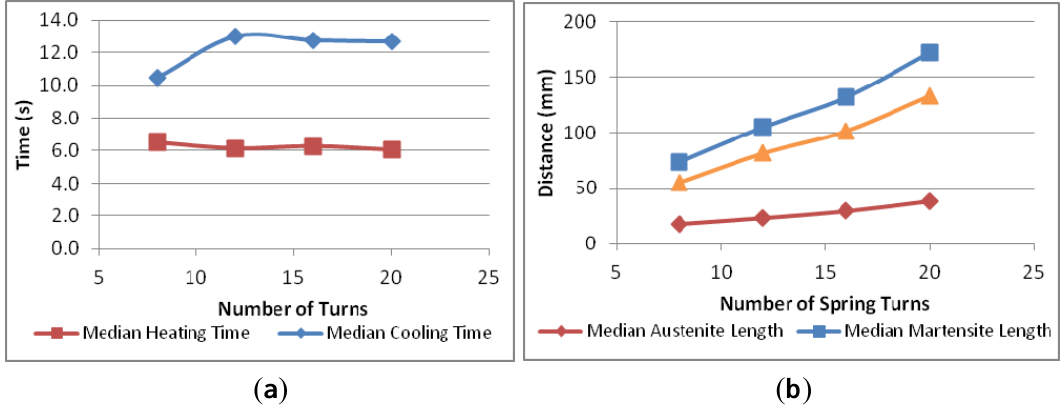
7. Experimental results from the number of active turns manipulation. ( a ) (Left) The averaged heat and cooling times. ( b ) (Right) The averaged strokes, martensite lengths and austenite